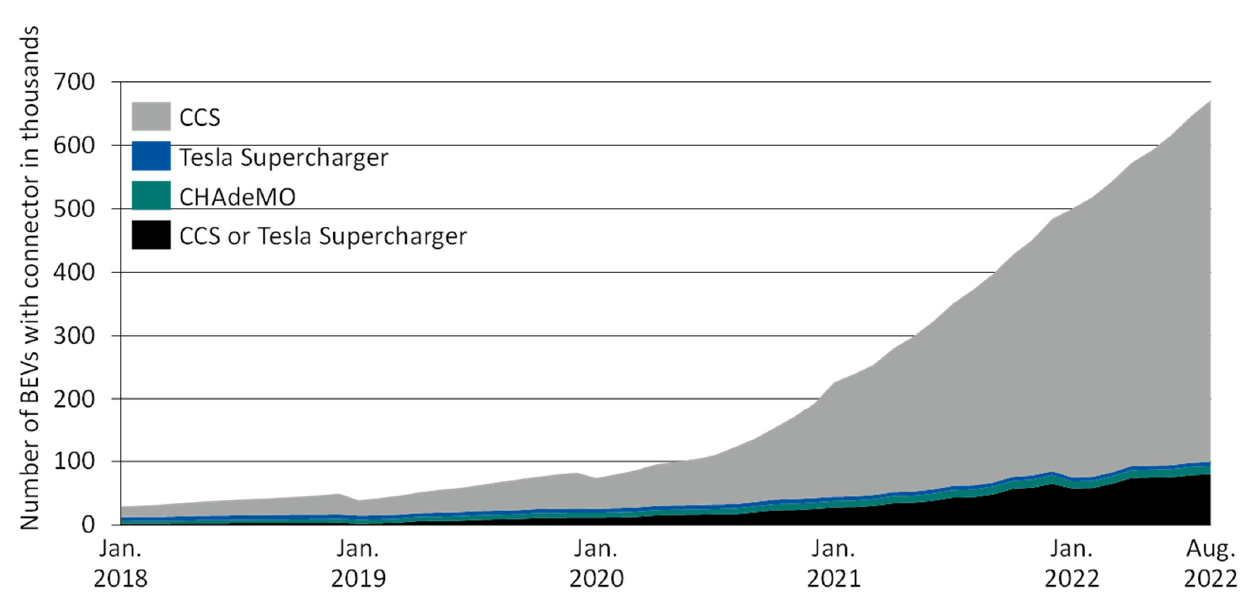
Figure 5. Number of BEVs equipped with DC fast chargers. The category “CCS or Tesla Supercharger” is comprised of vehicles for which the underlying data did not allow us to deduce which of the two these were, as Tesla has switched to the CCS for some models, and also uses the CCS as the only standard on V3 superchargers in Europe.